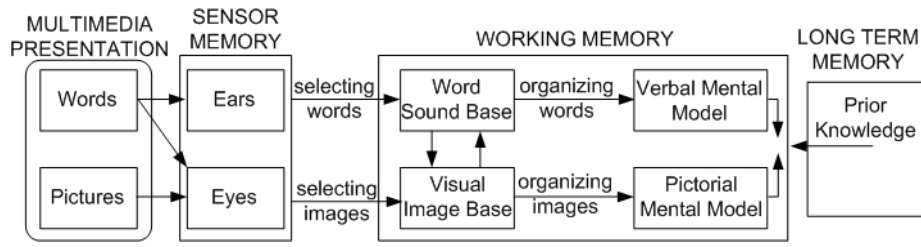
Figure 1 . The cognitive theory of multimedia learning (Mayer,